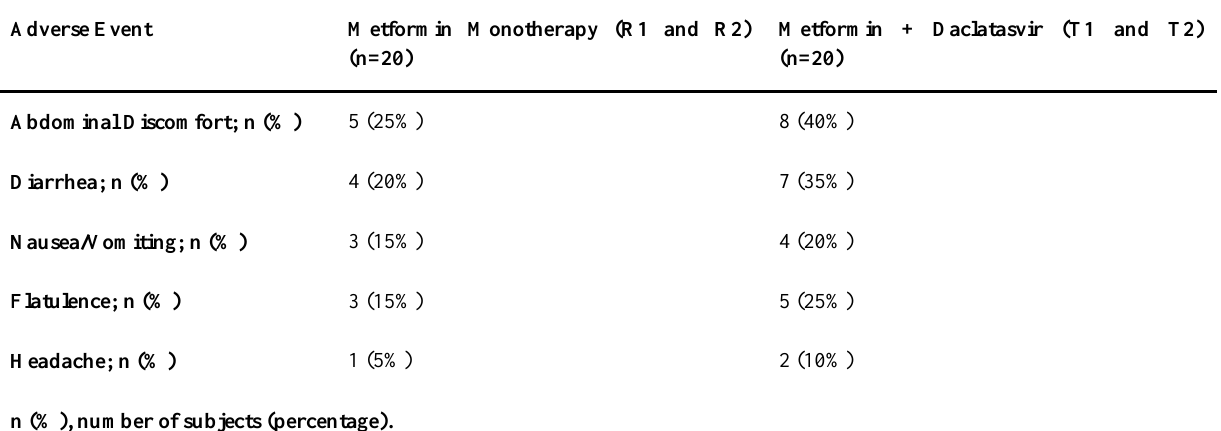
Table 1. Most common adverse events (> 5.0%) during the study per treatment